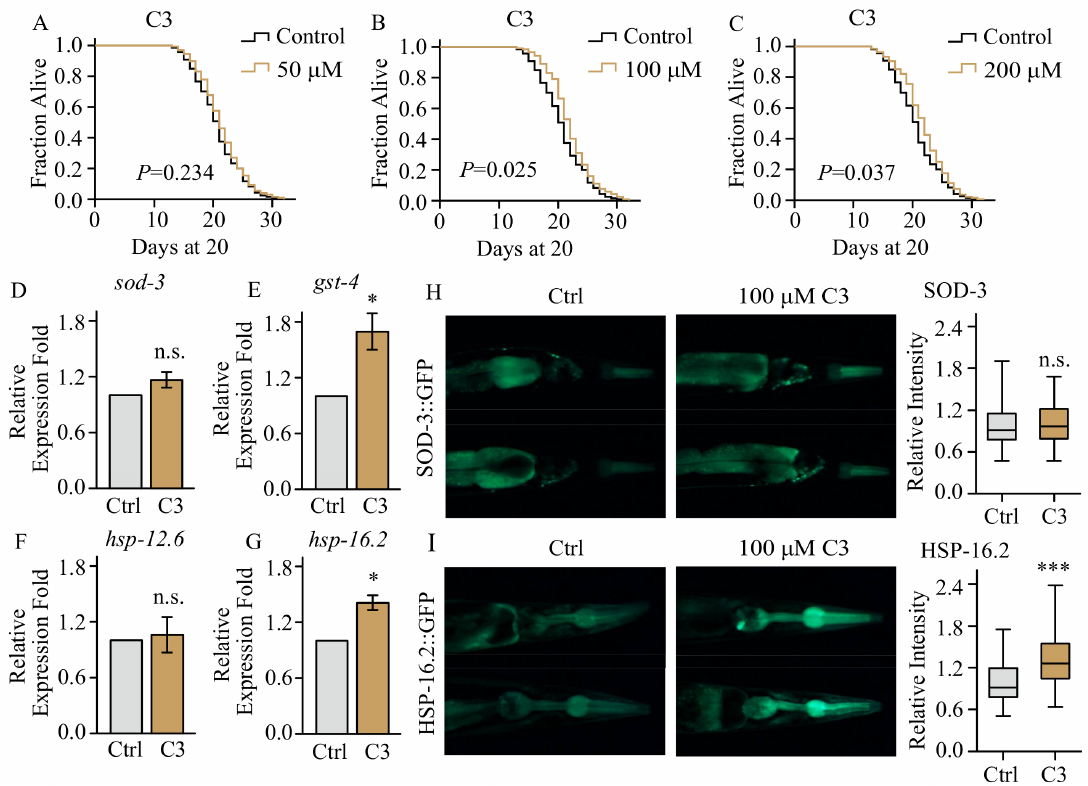
Figure 3. Compound 3 upregulated the expression level of stress response proteins GST-4 and HSP-16.2. ( A – C ) The survival curves of wild type worms rose at 20 ◦ C on NGM plates containing various concentrations of compound 3 . Lifespan was analyzed by Kaplan-Meier, and p values were calculated by log-rank test. For lifespan assay, at least 80 worms were used in each group, and three biological repetitions were performed; ( D – G ) The mRNA expressions level of sod-3 , gst-4 , hsp-12.6, and hsp-16.2 under the treatment of compound 3 . Figures show the mean value of three independent experiments, and error bars represent SEM. P values were calculated by two-tailed t -test, * p < 0.05; n.s. is not significant; ( H – I ) SOD-3::GFP and HSP-16.2::GFP were induced by compound 3 and observed under fluorescent microscopy. For HSP-16.2::GFP expression assay, age synchronized young adults with HSP-16.2::GFP were transferred to compound 3 treatment for 48 h, then shifted to 35 ◦ C for 2 h, and followed by recovery for 24 h. At least 40 worms were used in each group, and three biological repetitions were used in assays. Relative GFP fluorescence intensity was calculated by Image